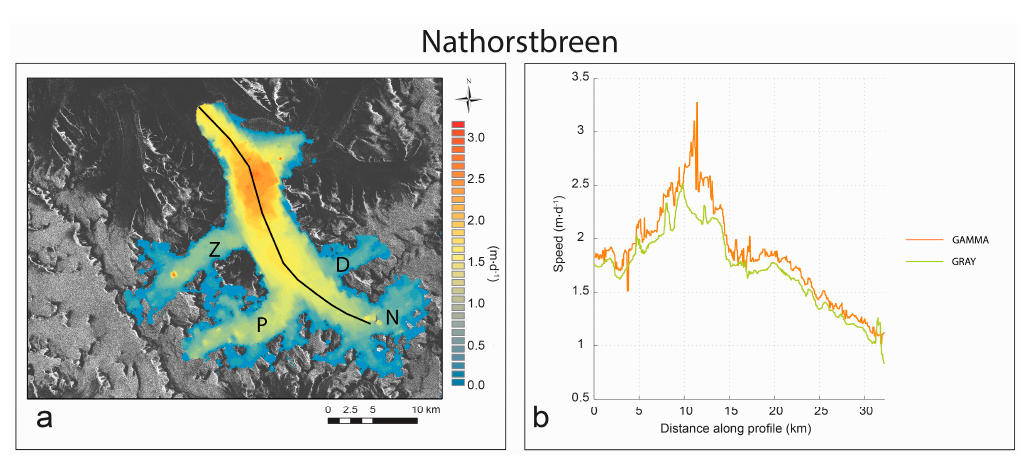
Figure 5. ( a ) Surface speed of Kronebreen (#1 in Figure 3) in NW-Spitsbergen (1–25 January 2013; WF; GRAY); and ( b ) speed profile along the centerline of Kronebreen (orange: GAMMA; green: GRAY).